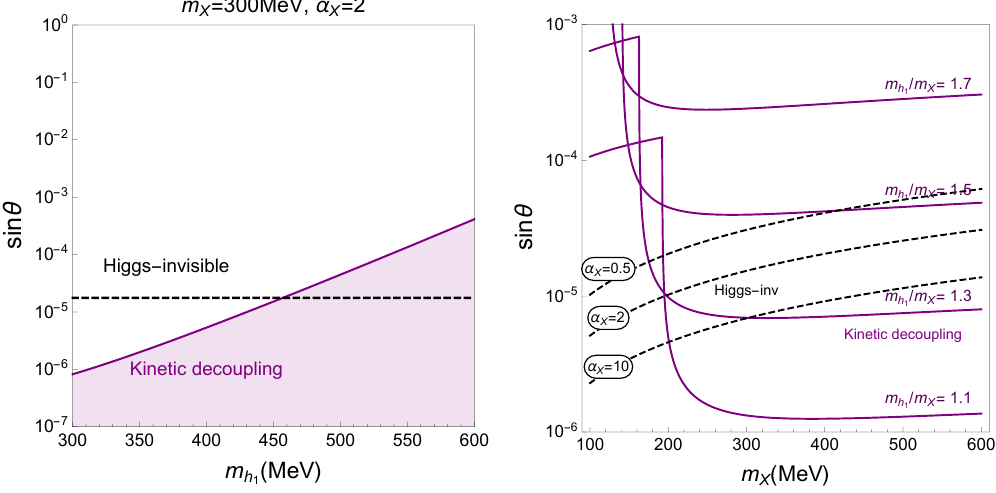
Figure 3 . Vector SIMPs through the Higgs portal, with DM-dark Higgs scattering and dark Higgs- SM decays. Left: parameter space of m h vs. sin (cid:18) for DM-dark Higgs scattering. The shaded purple 1 regions indicate where kinetic equilibrium between the DM and dark Higgs fails. Right: parameter space of m X vs. sin (cid:18) . The purple lines are the lower bounds on sin (cid:18) from kinetic equilibrium for (cid:12)xed ratios m h =m X . In both panels: the dashed black curves are the upper bounds on sin (cid:18) from 1 Higgs invisible